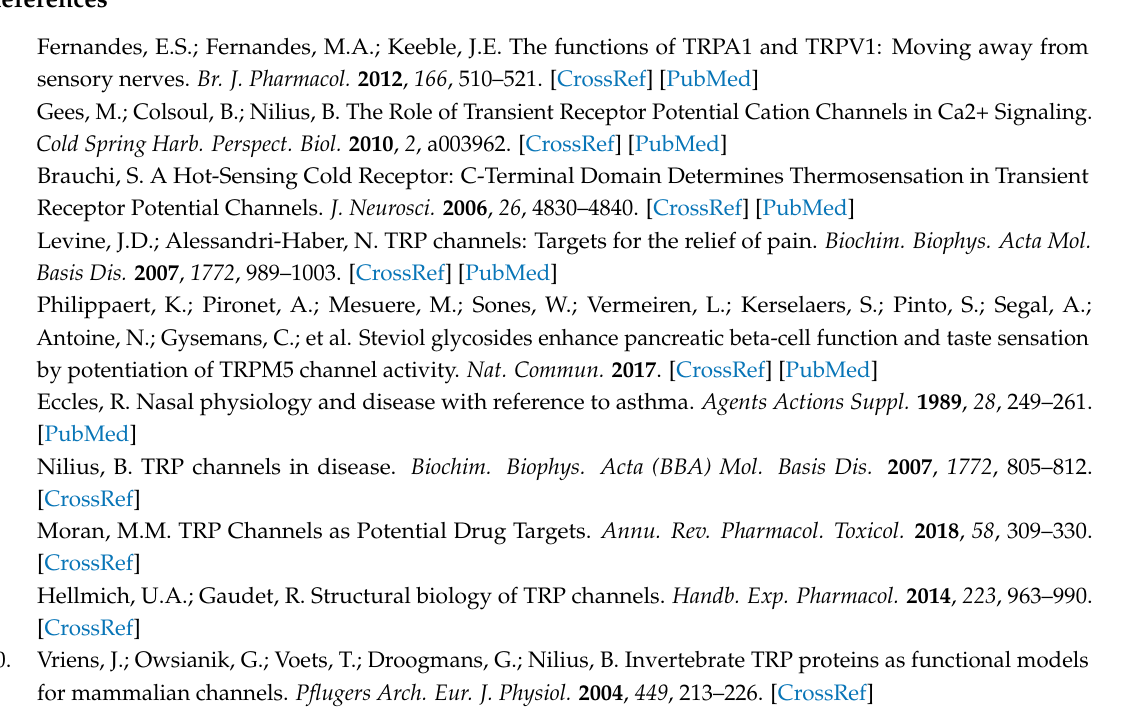
Table S1: Sequences of primers used to obtain recombinant transient receptor potential (TRP) channel constructs included in the study, Table S2: Solubilization of selected human TRP